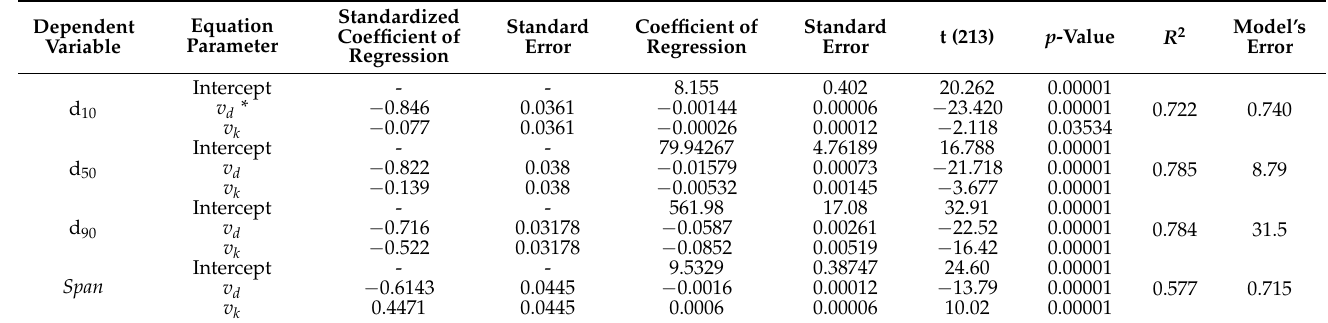
Table 4. Results of equations describing the relationships between the working parameters of the mill and the parameters describing the PSD of micronized OH.